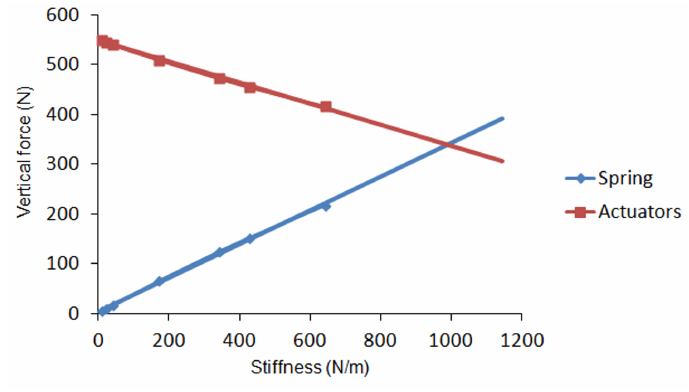
Figure 8. Effect of spring stiffness on vertical propulsive force exerted by the actuators at the hip, knee and fetlock joints.